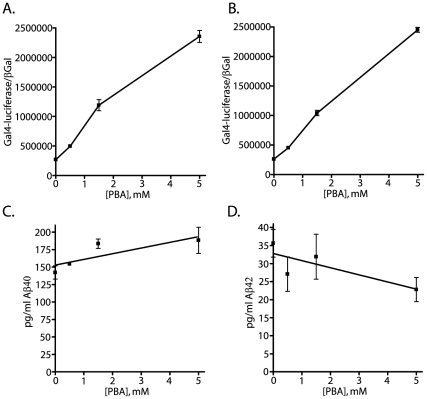
Amyloid biogenesis (Aβ40 and Aβ42) is unaffected by the PBA mediated stimulation in AICD production.The NAG cells were treated with titrated values of PBA (0, 0.5, 1.5, and 5 mM). A two-part assay measured γ-secretase dependent AICD production (A and B) and secreted amyloid biogenesis (C and D) from the same samples. The Gal4-reporter assays were performed with the cell lysate, while the media was assayed for species specific amyloid concentrations. PBA stimulated γ-secretase mediated proteolysis approximately ten-fold (A and B) in parallel assays to the ELISA measures for Aβ40 (C) and Aβ42 (D). Each concentration step in the PBA titration induced a statistically significant increase in Gal4-reporter activity ([PBA] shift: 0 to 0.5 mM, p<0.0003; 0.5 mM to 1.5 mM, p<0.0002; 1.5 mM to 5 mM, p<0.0001; analysis performed with the values in (A)). In contrast, there was no statistically significant change in either Aβ40 or Aβ42 levels. Aβ40 levels increased slightly from 142 picograms/ml to 188 picograms/ml, with a p-value of 0.09. In contrast, Aβ42 levels decreased from 35.6 picograms/ml to 22.7 picograms/ml, with a p-value of 0.06. In total, Aβ40 levels increased by 32.3 percent and Aβ42 levels decreased 36.05 percent—neither change reaching statistical significance. Each assay was performed in triplicate. The standard curves for Aβ40 and Aβ42 were linear in the tested concentration range with R2>0.96. Consequently, PBA stimulation of APP proteolysis occurs in a non-amyloidogenic manner.